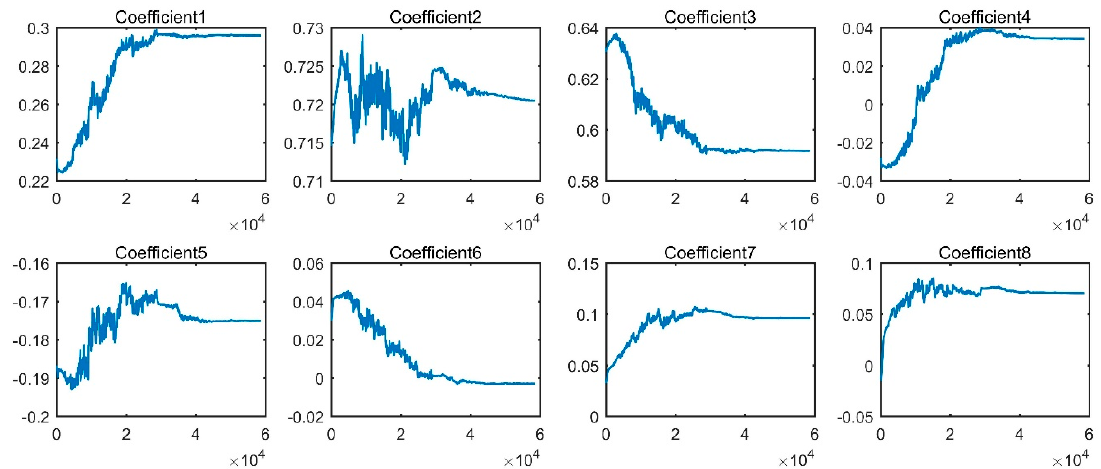
Figure 17. Optimization process of the WFCs of WPT-CNN-finetuned-db4.